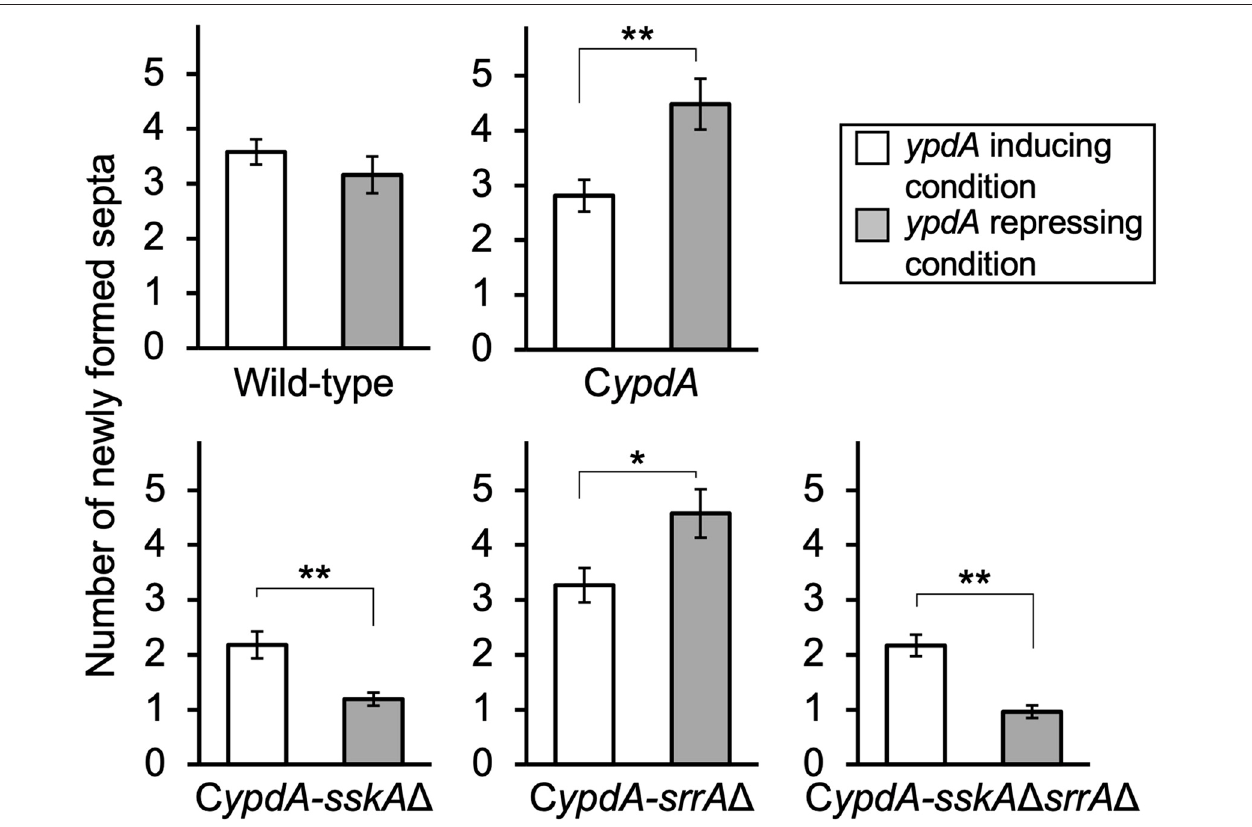
FIGURE 7 | Number of newly formed septa after medium transfer in the wild-type and C ypdA strains. The number of newly formed septa in mycelia germinated from a single conidium was calculated by subtracting the average number of septa produced during preculture (CDTFY at 37 ◦ C for 10h, ypdA -inducing) from that of septa counted after incubation for 4h after transfer to ypdA -inducing or -repressing medium ( n = 100 mycelia for each strain in each medium). Error bars represent the standard errors of the mean. * P < 0.05, ** P < 0.01; Welch’s t